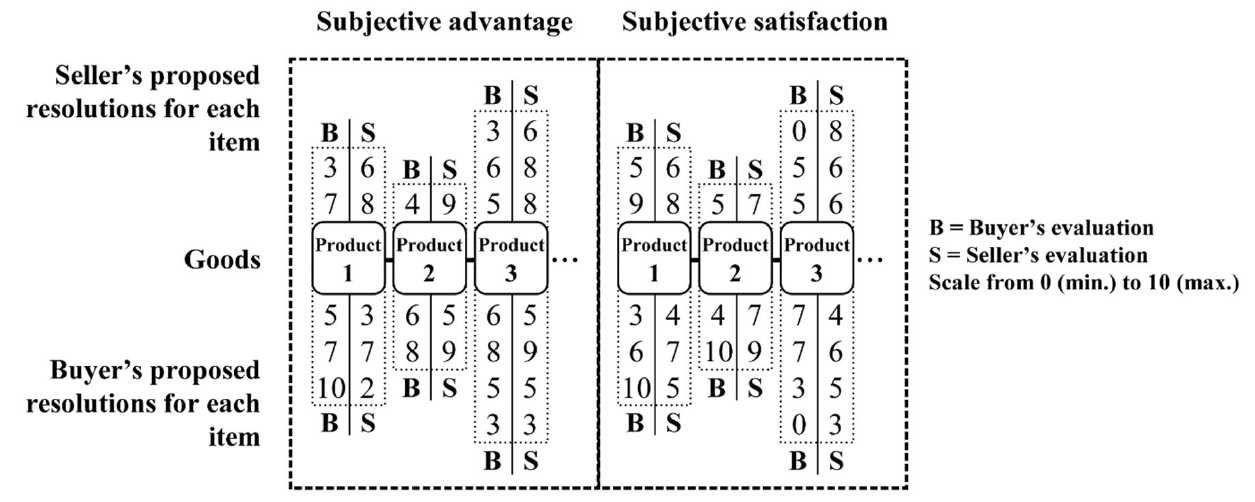
Figure 4. Assessment of the proposed resolution of the dispute (Phase 3 of the E ‐ NeGotiAtion method).